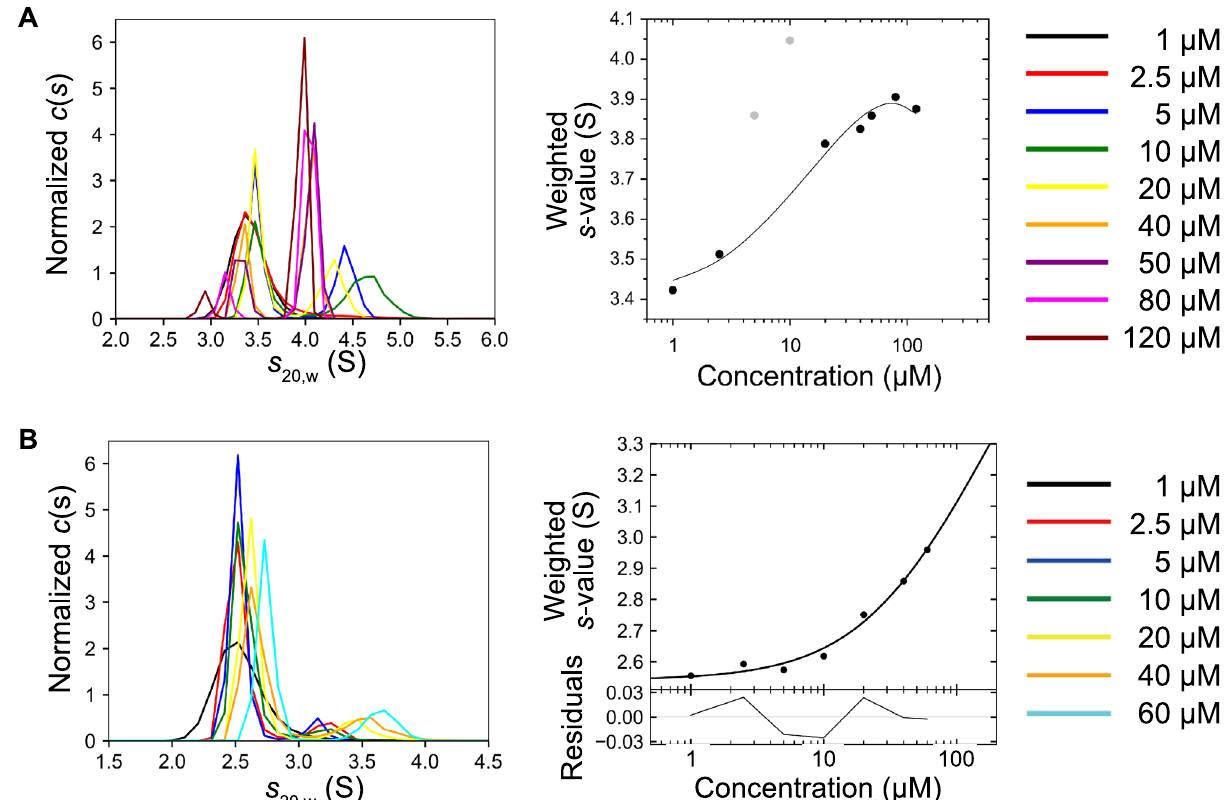
Figure 2. Sedimentation plots of sedimentation velocity-analytical ultracentrifugation (SV-AUC). ( A ) EC1- 4K115E, ( B ) EC1-2K115E. Dimerization of EC1-4K115E and EC1-2K115E was confirmed. K D of EC1-4K115E and EC1-2K115E homodimer was 51.6 µM and 343 µM, respectively. The SV-AUC data of EC1-4WT and EC1- 2WT are reported previously 9 . K D for EC1-2K115E was determined assuming that the s -value of EC1-2K115E is the same as that of EC1-2 homodimer 9